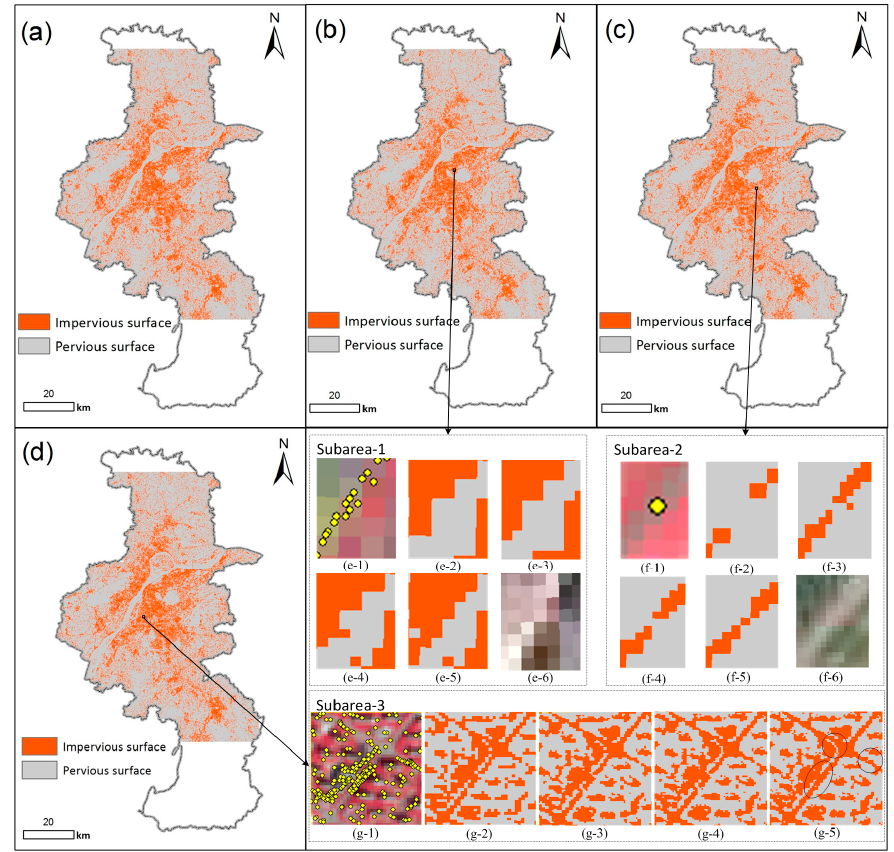
Figure 4. Experimental results using a Sentinel-2 image. ( a ) Support vector machine (SVM)